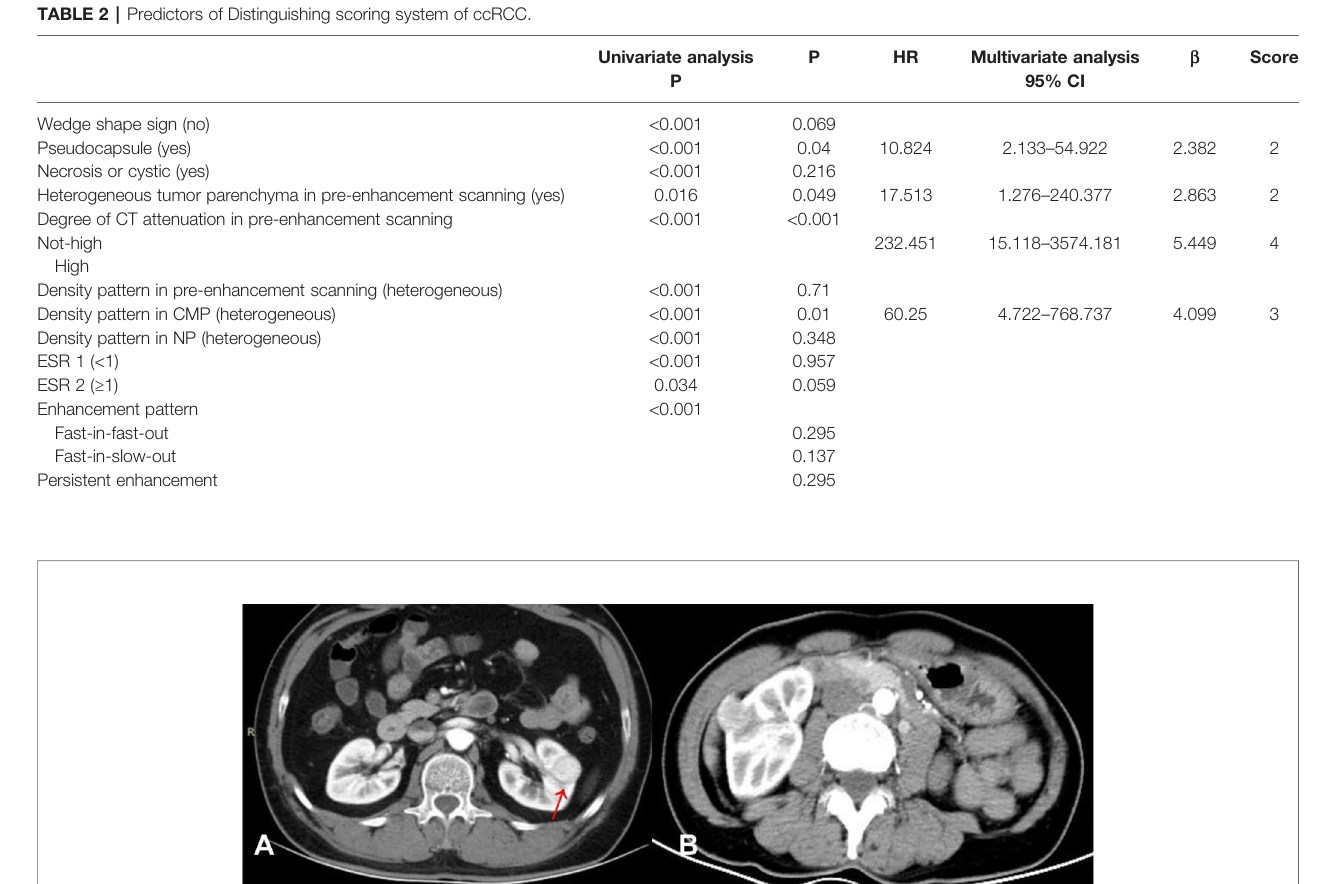
TABLE 2 | Predictors of Distinguishing scoring system of ccRCC.